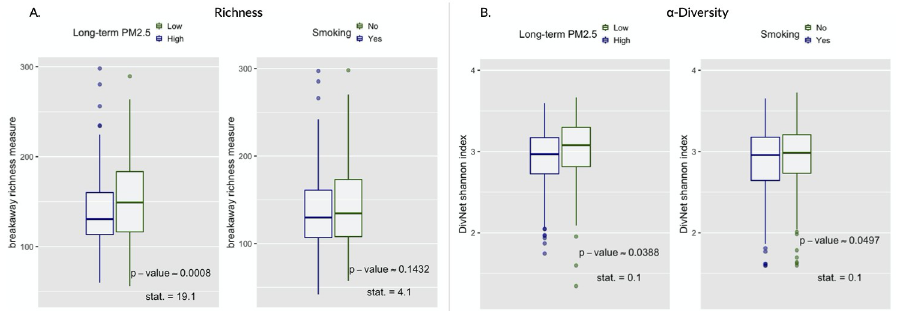
Fig 2. Richness and α -diversity. Boxplots (with median), values of the test-statistics from the betta regression [54], and one-sided randomization-based p-values for 10,000 permutations of the intervention assignment following a matched-pair design. (A) Boxplots of the richness. (B) Boxplots of the α -diversity.